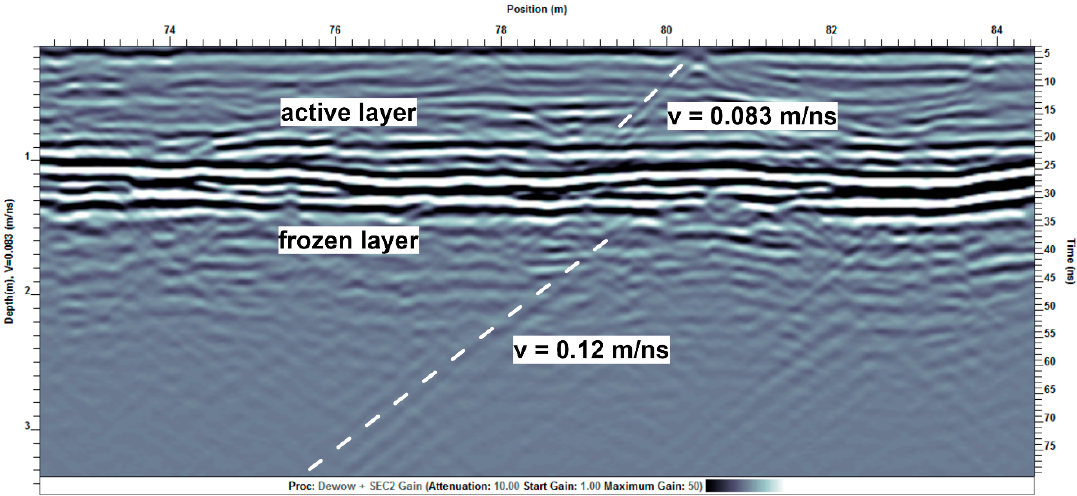
Figure 4. Permafrost table in July 2016 at the Old Whaling Ridge. The frozen interface results in a sudden velocity increase, along with changes in diffraction tails that indicate an average velocity change. Here the active layer is ca. 1 m thick before frozen ground is encountered.